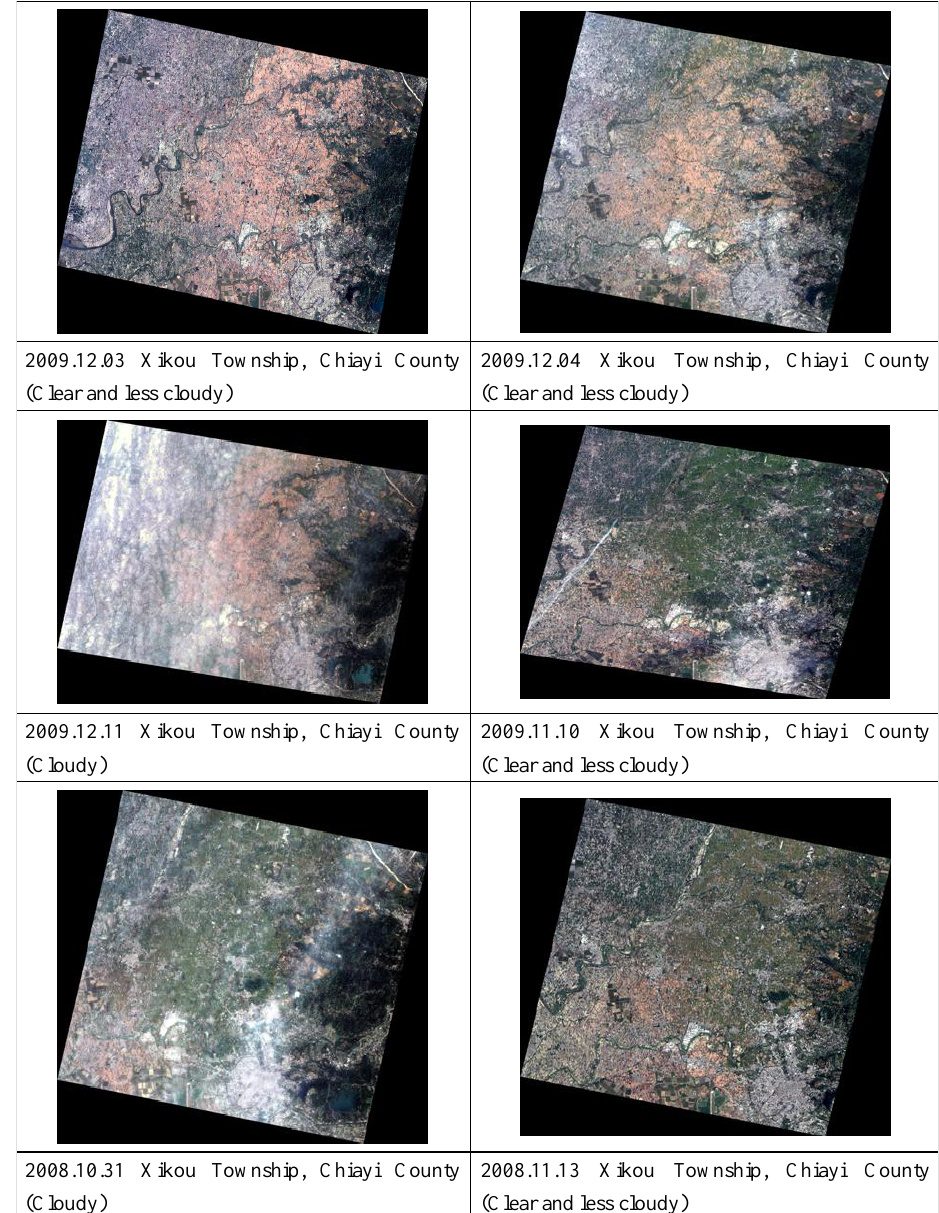
Fig.2 Satellite image processing before and after the harvest in 2008 and 2009 in Fig. 2. Satellite image processing before and after the harvest in 2008 and 2009 in Xikou Township, Chiayi County. from a site-inspection conducted by the Environmental Pro- tection Bureau of Chiayi County in 2009 as training data for classification, and then on the basis of these sites plot the ex- tent of agricultural land. The main locations are Hsinkang, Xikou Township and Minsyong Township in Chiayi County in southwest Taiwan. The green markers in the satellite im- ages show the distribution of the rice paddy areas (Fig.